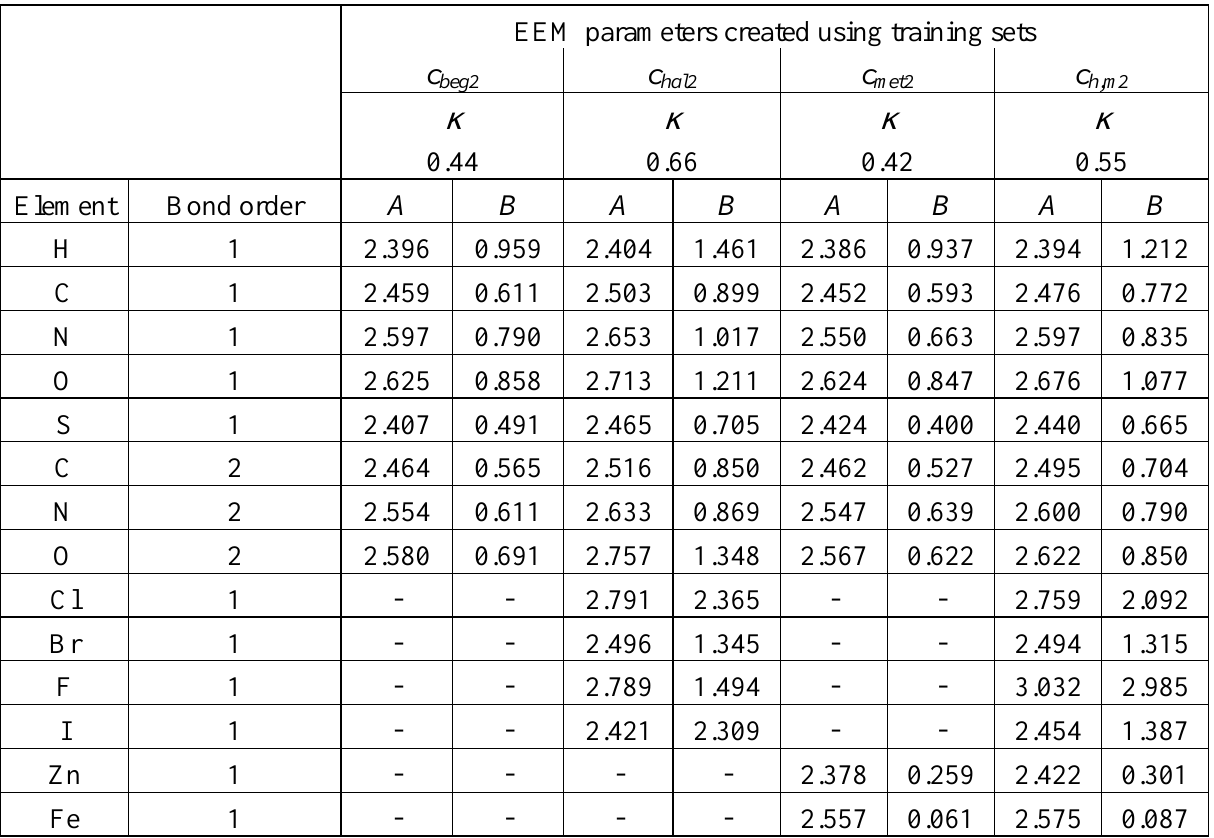
training sets c , c , c and c beg2 hal2 met2 h,m2